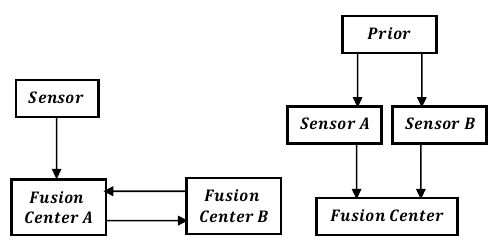
Figure 3. Causes of Double Counting.